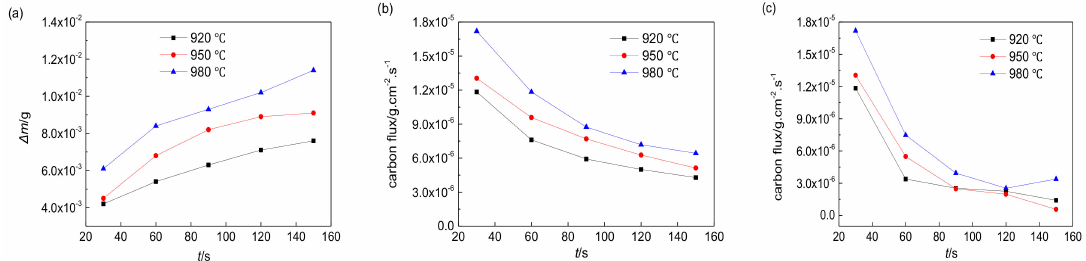
Figure 10. E ff ect of carburizing temperature on ( a ) mass increment, ( b ) average carbon flux, and ( c ) segmented average carbon flux of 12Cr2Ni4 steel under 300 Pa.